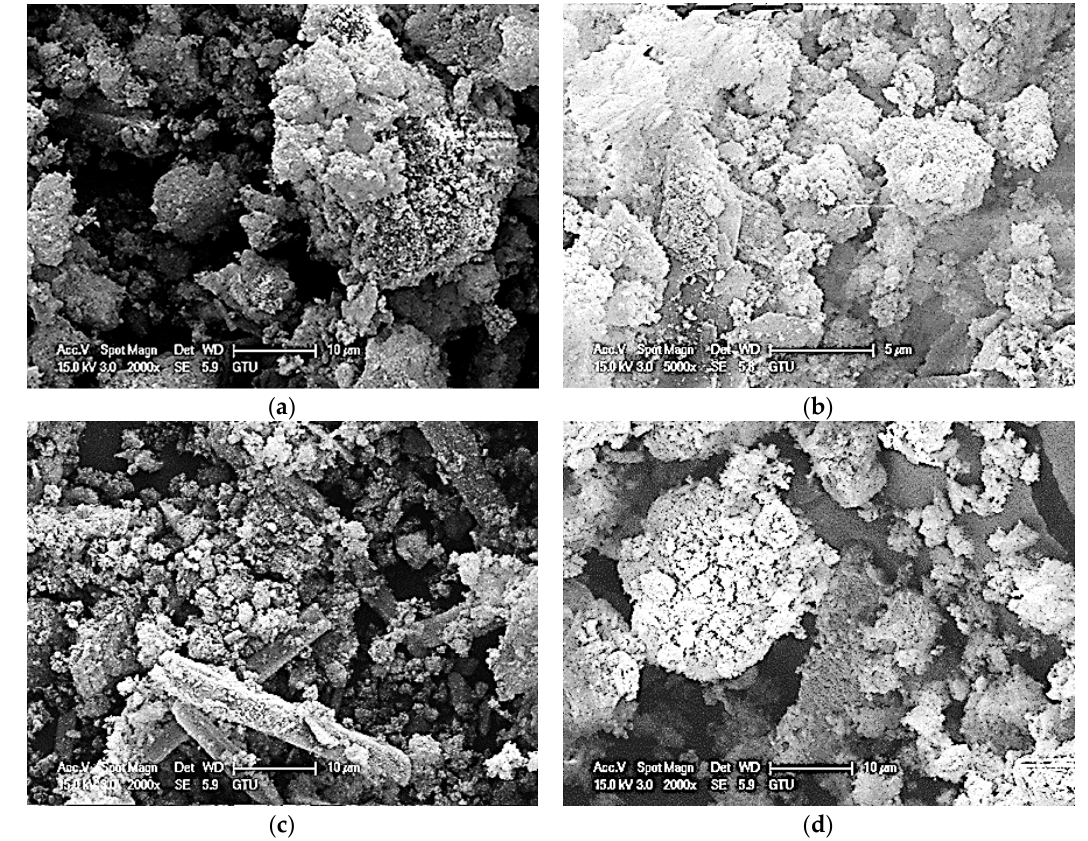
Figure 6. SEM images of model adhesives used in Phase 2 of the study. ( a ) P2AD2 (2000×); ( b ) P2AD3 (5000×); ( c ) P2AD4 (2000×); ( d ) P2AD5 (2000×).